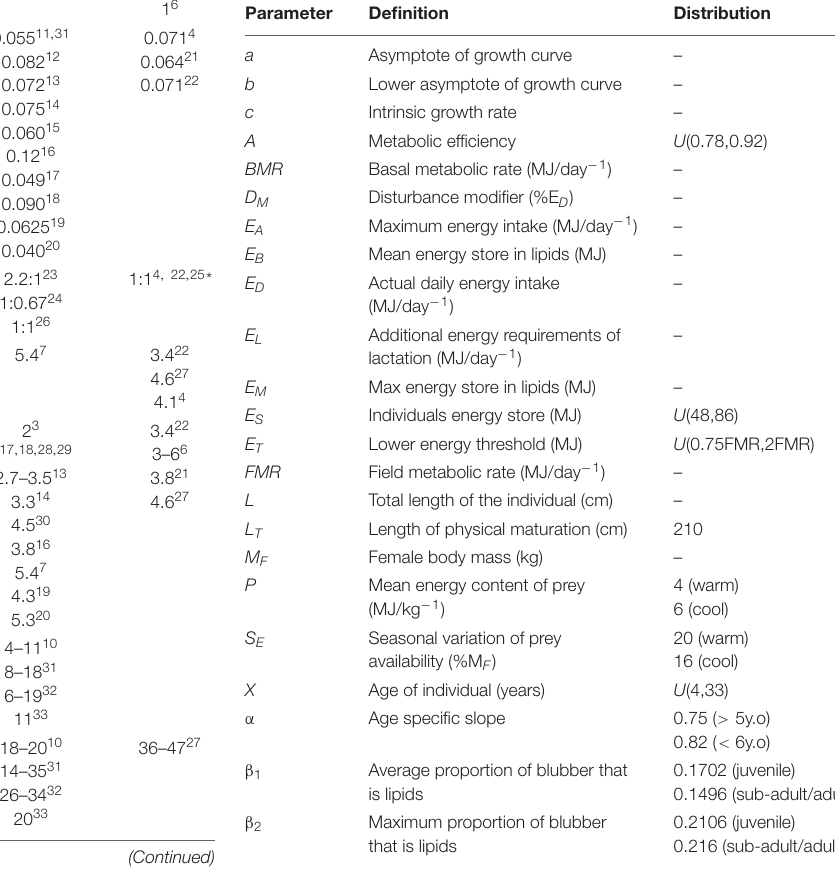
TABLE 2 | List of model parameters, their definition, and the distribution they were sampled